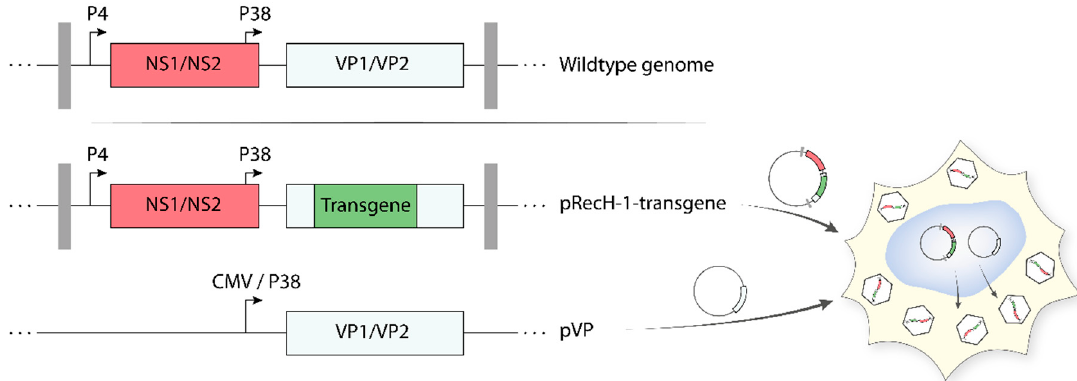
Figure 5. Production of recombinant H-1PV. For the production of recombinant H-1PV, a part of the VP1/VP2 region of the wild-type genome is removed and replaced with a transgene (in green).